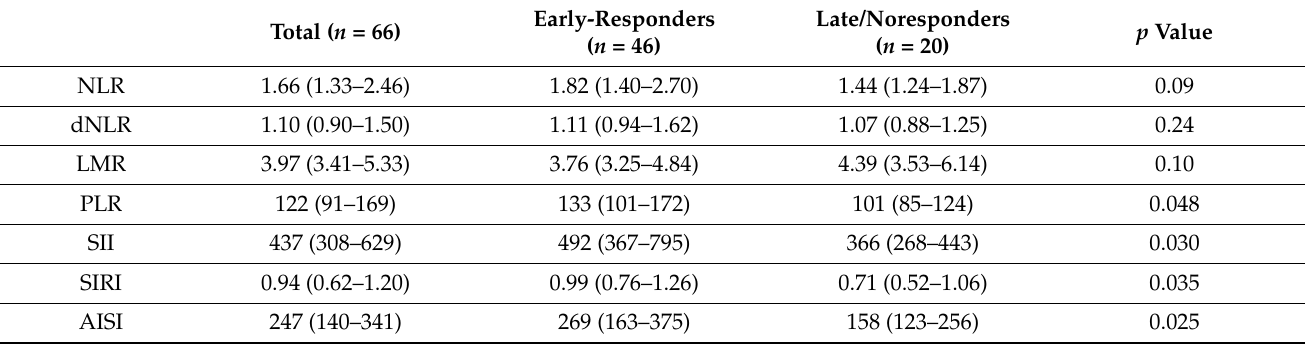
Table 3. Baseline combined haematological parameters in early-responders and late/non-responders.